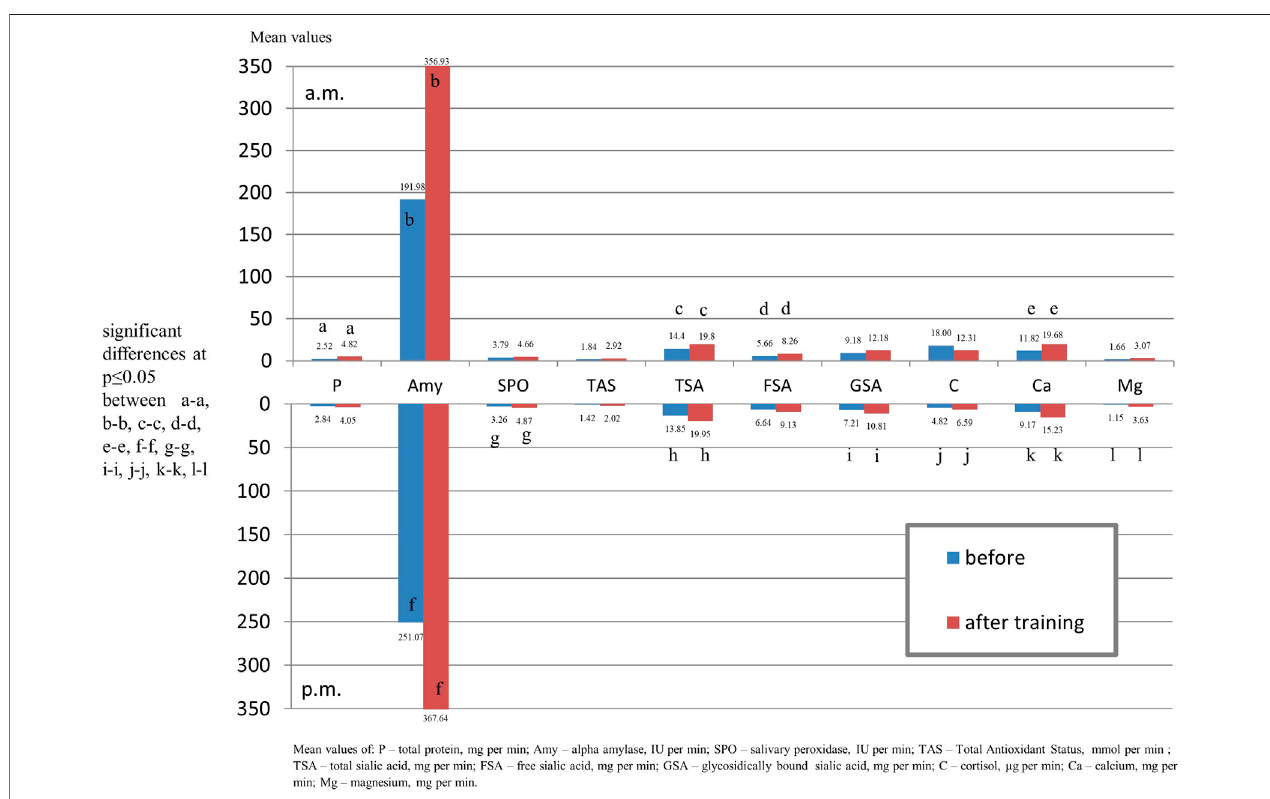
FIGURE 2 | Output of salivary components (mg/µg/U per min.) of youth swimmers before training and youth non-swimmers in the morning and afternoon hours.